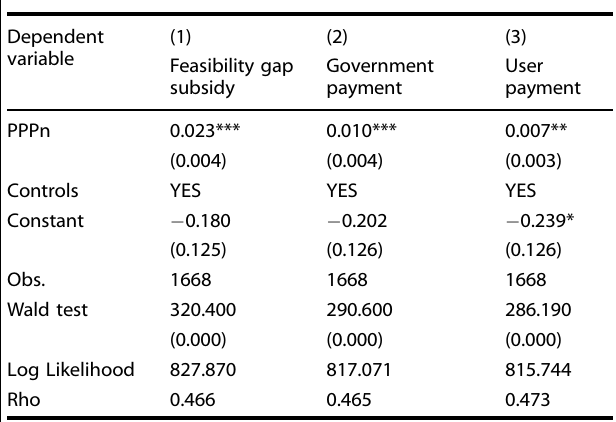
Table 4. Effect of the return